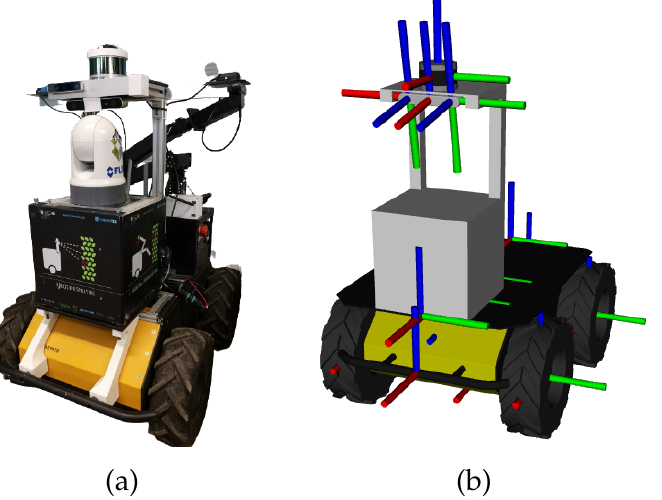
Figure 14. AgRob V16 is an Automated Guided Vehicle (AGV) used for agronomic purposes. It consists of a 3D LiDAR and a stereo camera system.